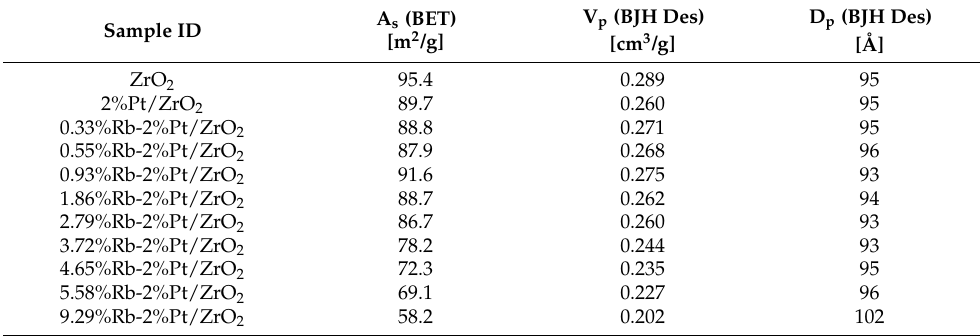
Table 1. Surface area (A S ), pore volume (V P ), and average pore diameter (D P ) for prepared catalysts.